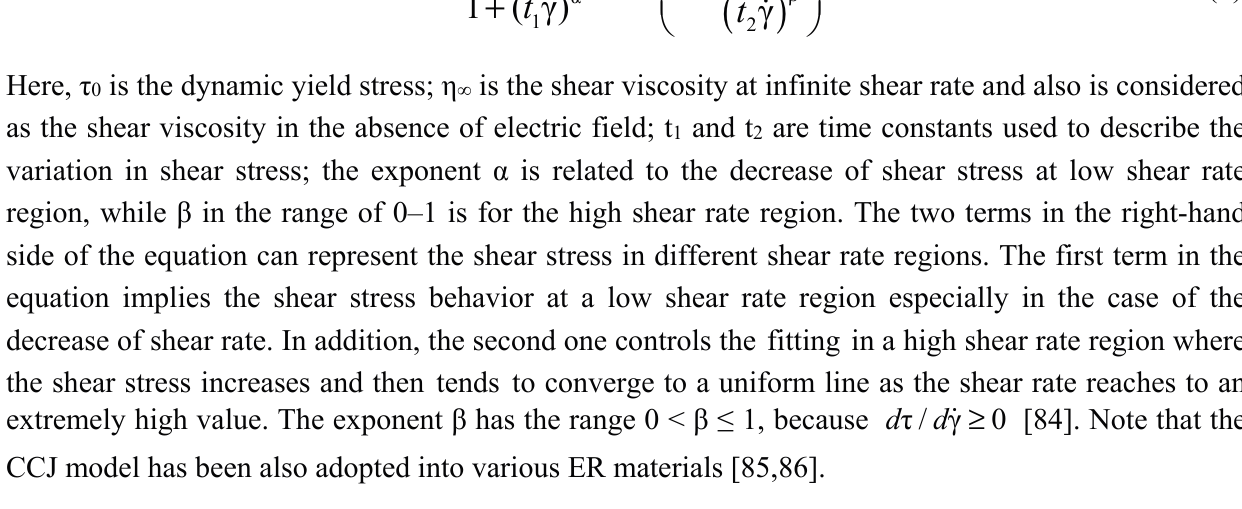
Figure 6. Shear stress vs. shear rate for a Si–GO composite-based ER fluid. The solid and dotted lines are fitted to the Cho–Choi–Jhon (CCJ) and Bingham models, respectively (Reprinted with permission from [33], copyright 2014